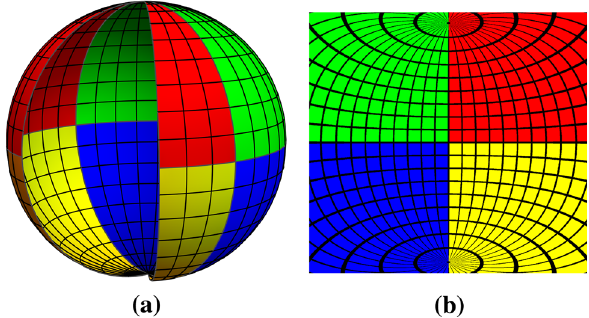
Fig. 7 The celestial sphere in a , and the observational image of the celestial sphere in the Minkowski spacetime in